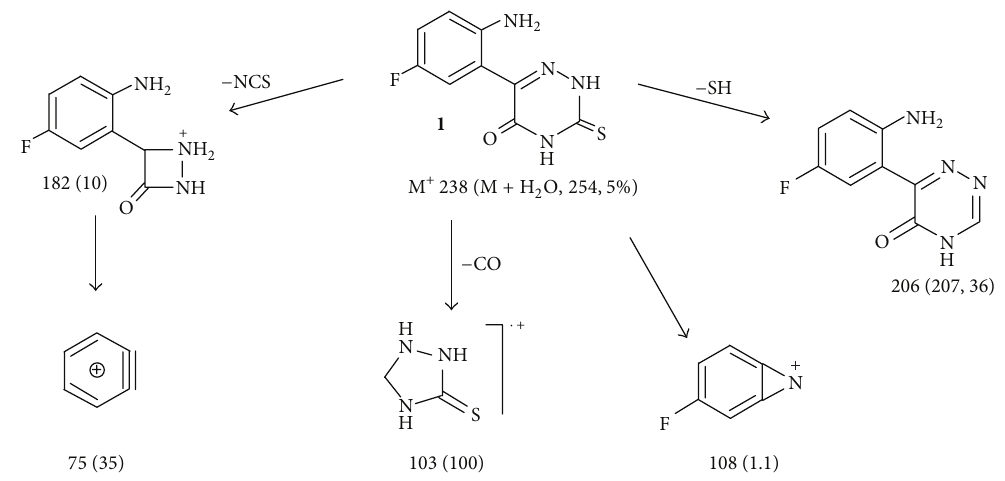
Scheme 6: Mass fragmentation pattern of compound 1 .